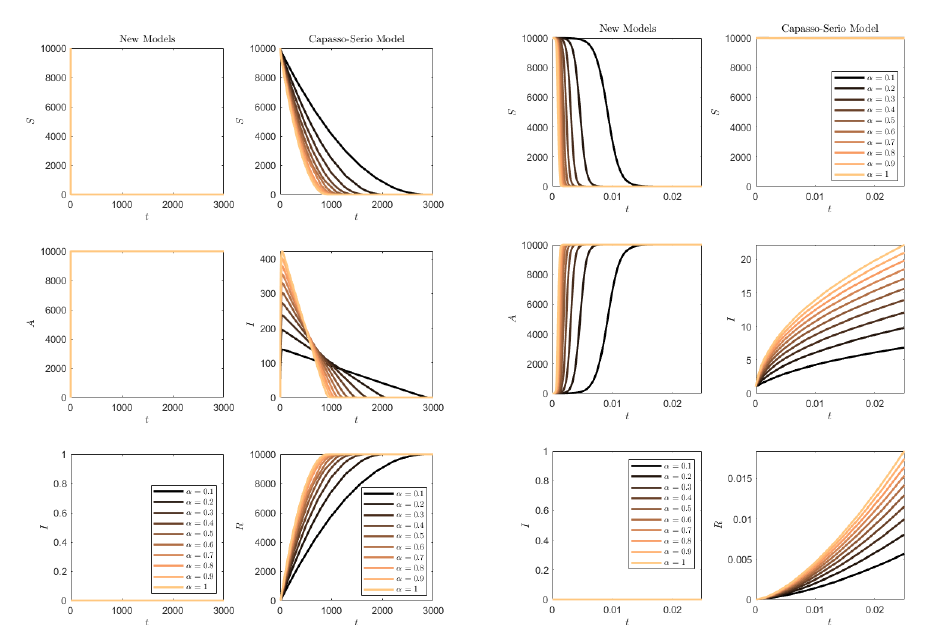
Figure 12. Here, we illustrate the case 0 = π < α ∈ [ 0.1 . . . ,1.0 ] , γ = 0.05. In this case, in the SAI model, the whole population is quickly affected, while for (73), the disease propagates at a lower speed with a lower transmission rate. In the long run, here as well, the susceptible class is depleted. Left frame: the simulations to show the settling of the systems. Right frame: the time interval is shorter to better show the transients in the SAI model. Other parameter values are (74) and initial conditions (50).